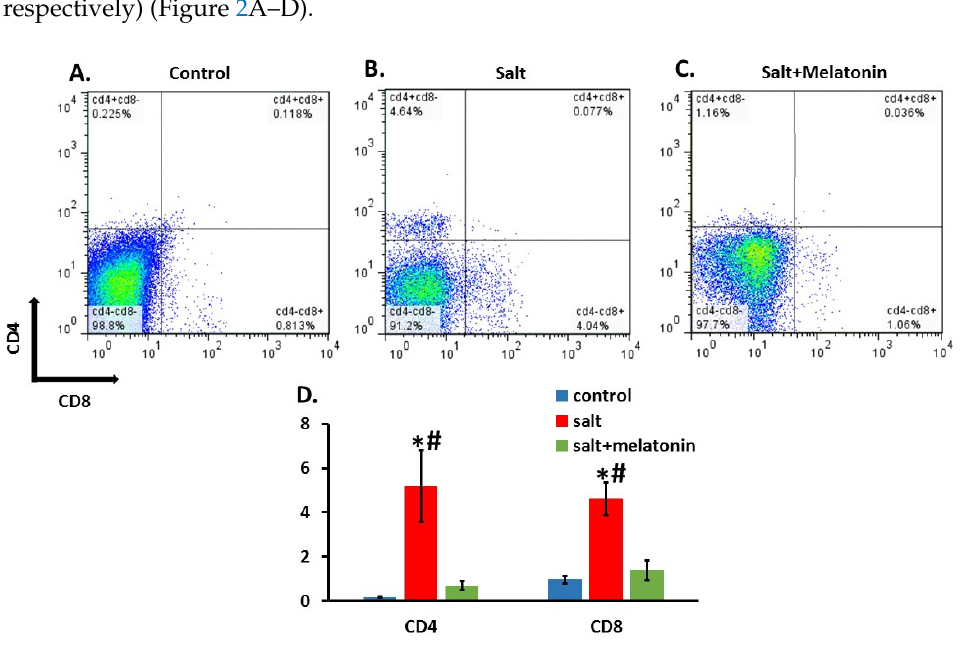
Figure 1. Melatonin ameliorated blood pressure and survival in HSD. DSS Rats were treated for 9 weeks with HSD with and without melatonin. High-salt diet reduced body weight from day 36 and melatonin moderated this effect ( A ). HSD increased mortality rate from day 40. Treating HSD-fed rats with melatonin improve their survival. ( B ). ( n = 8) *- p ≤ 0.05 salt and salt+melatonin versus